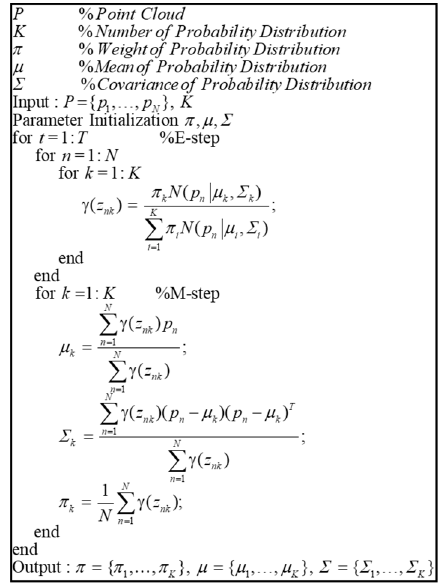
Figure 14. Pseudocode of the expectation–maximization (EM) algorithm for Gaussian mixture modeling (GMM).